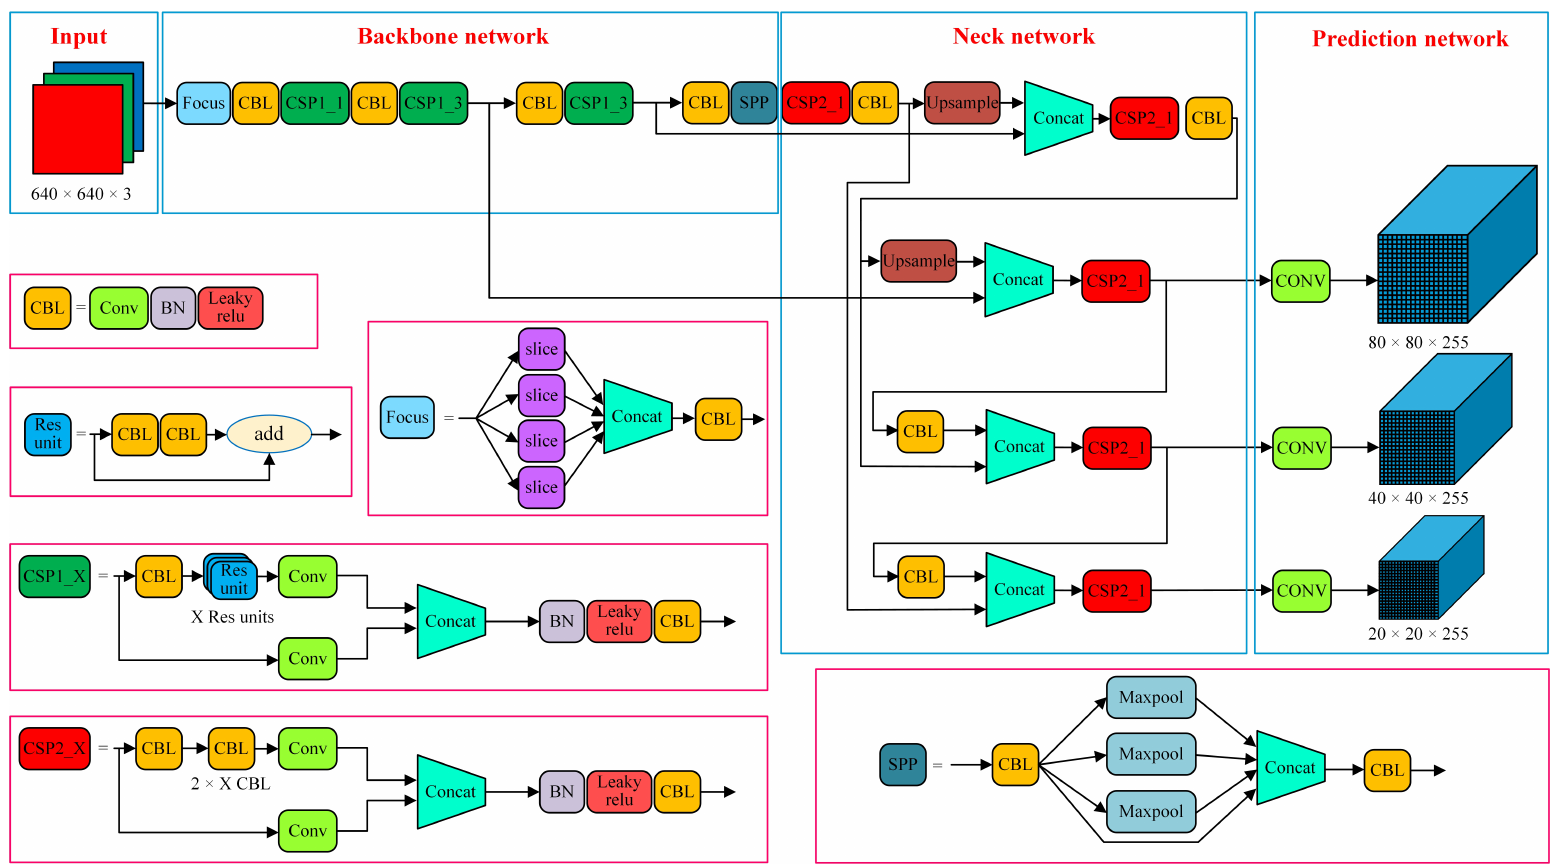
Figure 1. The network structure of YOLOv5, which is composed of the input module, backbone network, neck network, and prediction